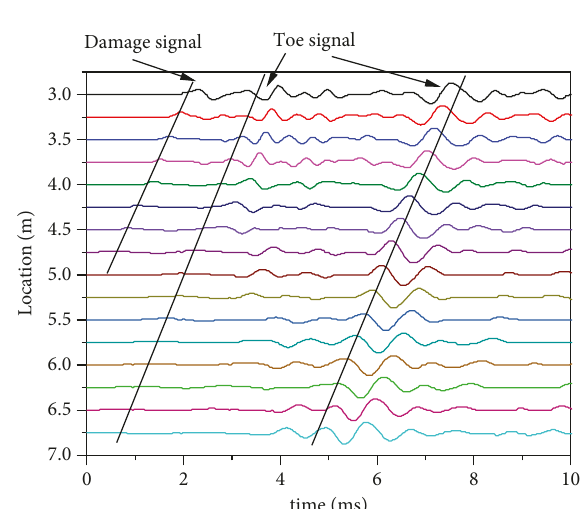
Figure 11: Upward velocities of the test data ( A